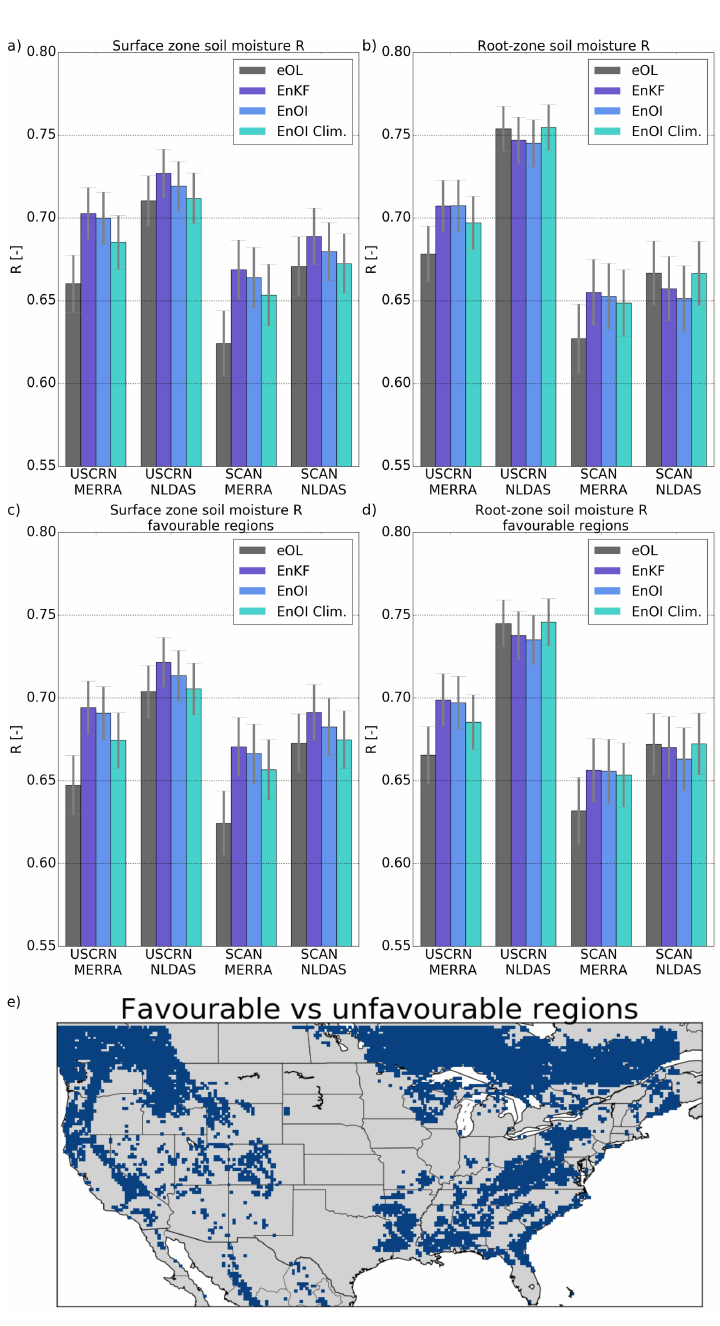
Figure 7. Summary statistics for the Pearson R correlation coefficient between the model and in situ data, a 95% confidence interval for the domain averaged correlation values are given as grey error bars. ( a ) domain average surface zone R, eOL (black), EnKF (dark blue), EnOI (light blue) and EnOI-Clim (turquoise); ( b ) domain average root-zone R; ( c ) domain average R “favourable” regions surface zone; ( d ) domain average R “favourable” regions root-zone; ( e ) favourable (grey land pixels) vs. unfavourable (blue land pixels) regions for soil moisture DA. See text for description of “favourable” vs. “unfavourable”